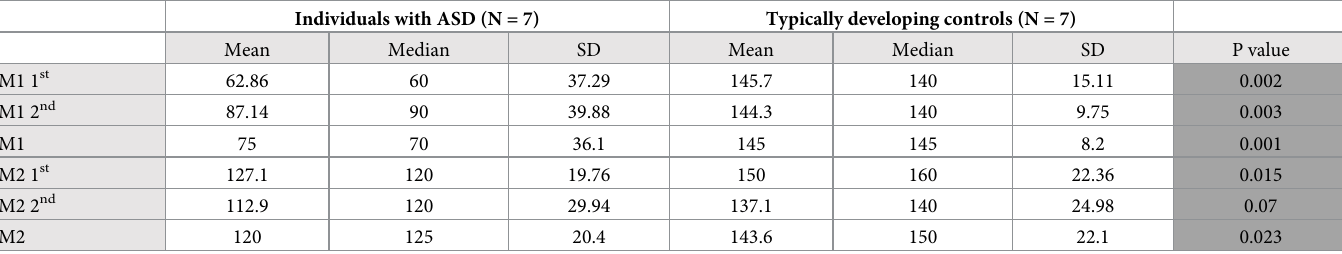
Table 2. Comparison of the results for the recognition task between individuals with ASD (N = 7) and typically developing controls (N = 7) for the first passage back and forth (M 1st), the second passage back and forth (M 2nd) and mean value (M). Individuals with ASD (N =